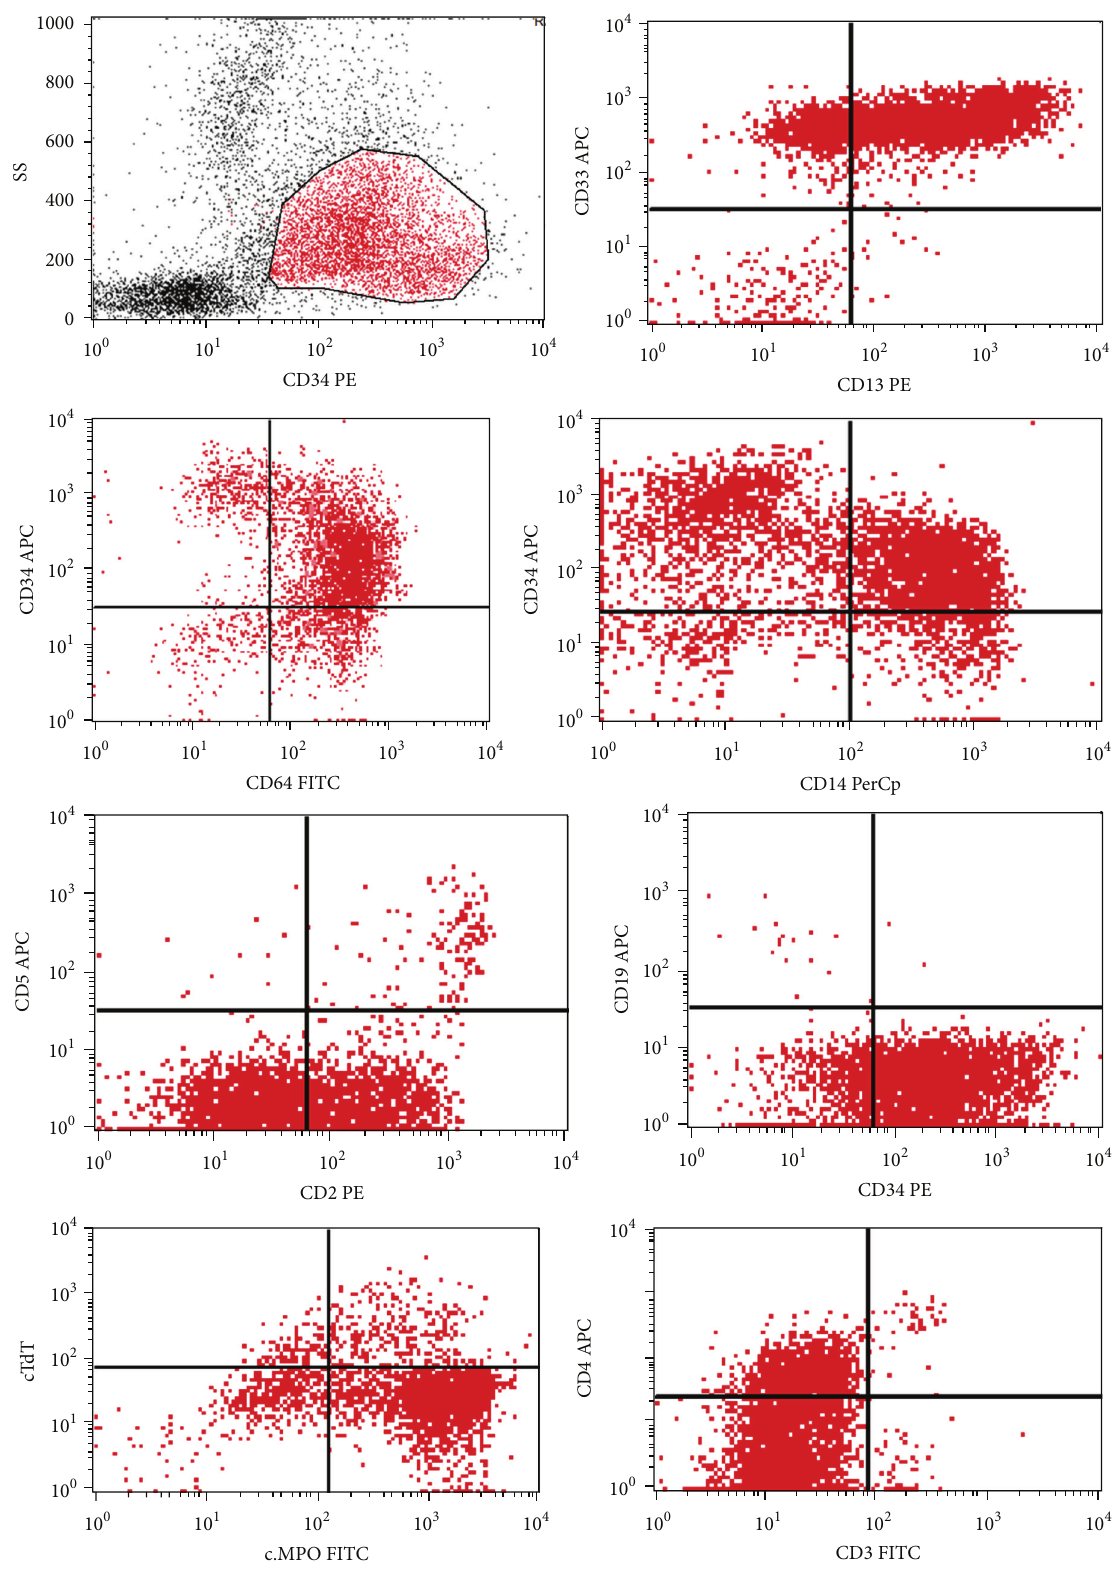
Figure 1: Flow cytometry analysis on PB samples using side scatter (SS) and CD34 positive cells. The blasts showed positivity to CD34, CD33, CD13, CD14, CD64, MPO, CD2, and CD4 and negativity to CD19, CD3, CD5, and TdT. MPO: myeloperoxidase. TdT: terminal deoxynucleotidyl